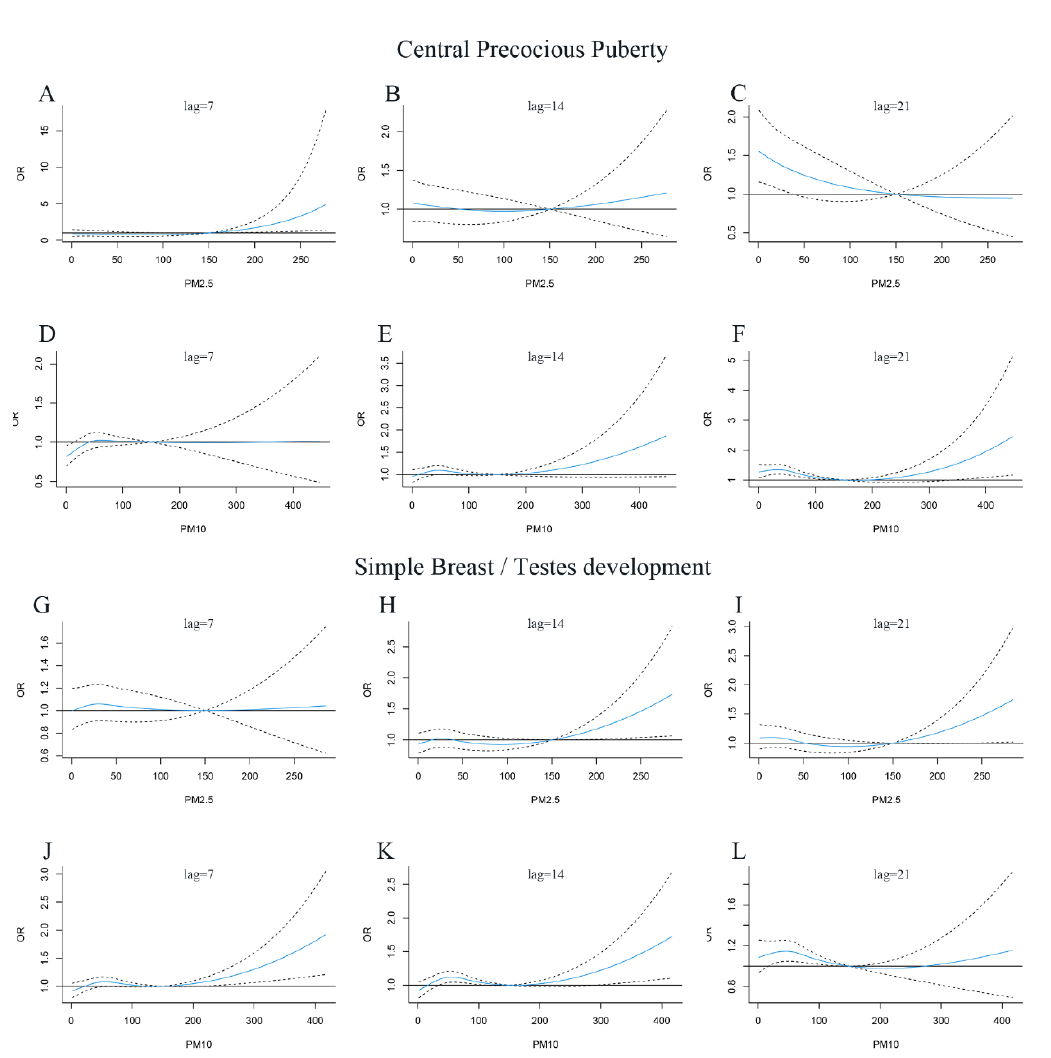
Figure 4. The three-dimensional (3D) plots of lag associations up to 28 days of PM 2.5 ( A , C ) and PM 10 ( B , D ) exposure with odds ratios (OR) of central precocious puberty and simple breast/testes devel- opment.